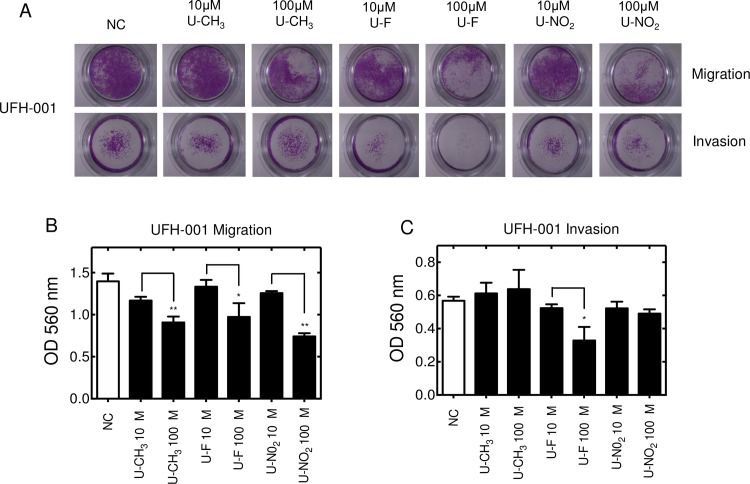
Effects of USBs on UFH-001 cell migration and invasion.Serum starved UFH-001 cells were allowed to either migrate for 24 h or invade for 48 h towards a chemoattractant in the presence or absence of USB compounds. Bright-field images of migrating and invading cells are shown in Panel A. Data are quantified for migration (Panel B) and invasion (Panel C). NC = negative control. Data shown are an average of duplicate experiments ± SEM. *p < 0.05, and ***p < 0.001.